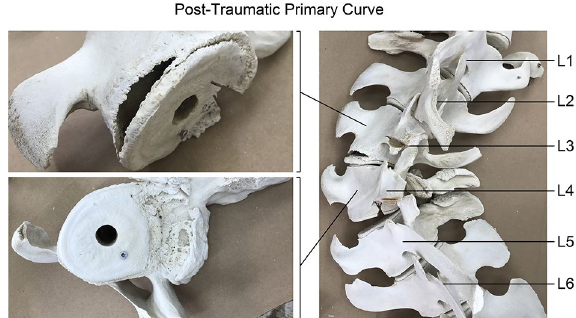
Figure 2. Photographs of the post-traumatic primary curve after removing the soft tissues. The dorsal overview on the right-hand side shows the post-traumatic primary, abrupt coronal curve at level L3/L4. Close-up inspection reveals an epiphysiolysis at the left-side of the lower endplate of vertebra L3, and a burst upper endplate at the right-side of vertebra L4. Furthermore, fractured spinous processes at multiple levels are present. There are multiple post mortem marks following tissue selection for histopathology, and also centre holes and screws that were drilled through the endplates in the process of framing the complete skeleton for museum display. These artefacts did not influence the presented post-traumatic features.